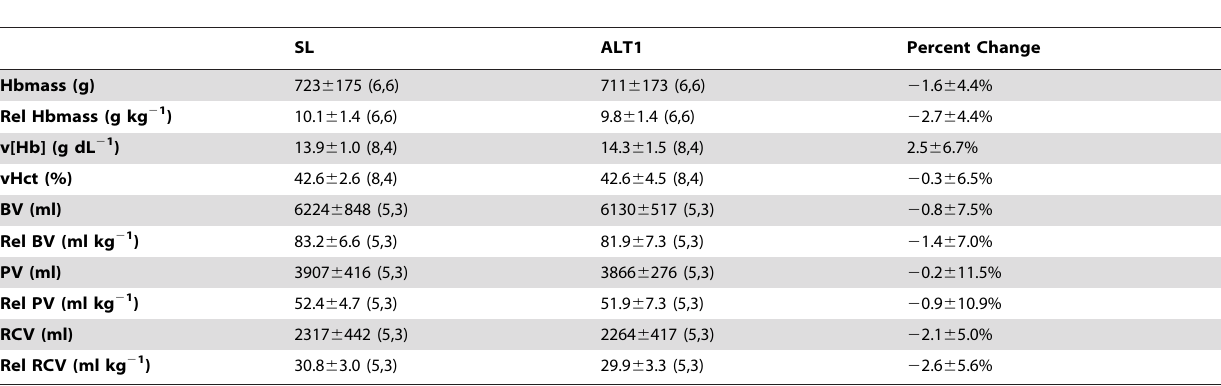
Table 2. Hematological parameters at sea level and the first day of exposure to 5260